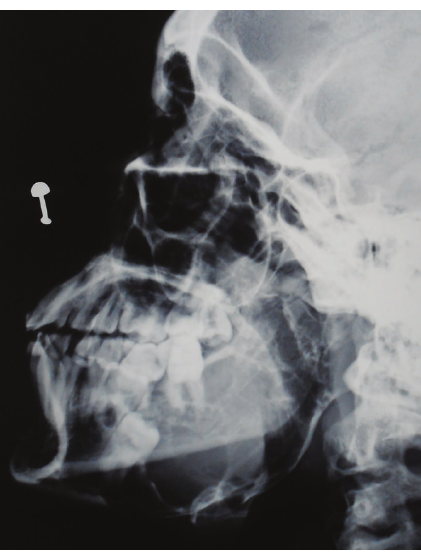
Figure 4: Lateral cephalogram of the patient showing expansion of the lower border of mandible.